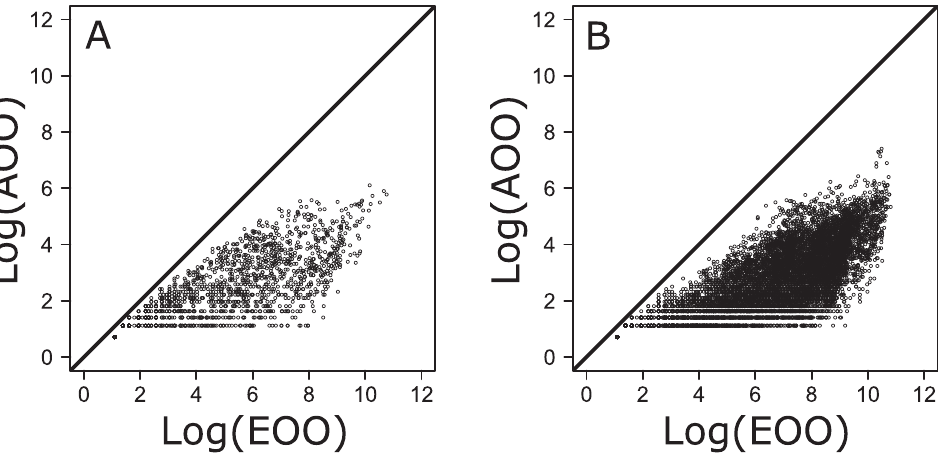
Figure 4. Relationship between fish species extent of occurrence (EOO) and area of occupancy (AOO). Both variables are logarithmically transformed (A: freshwater dataset; B: marine dataset).